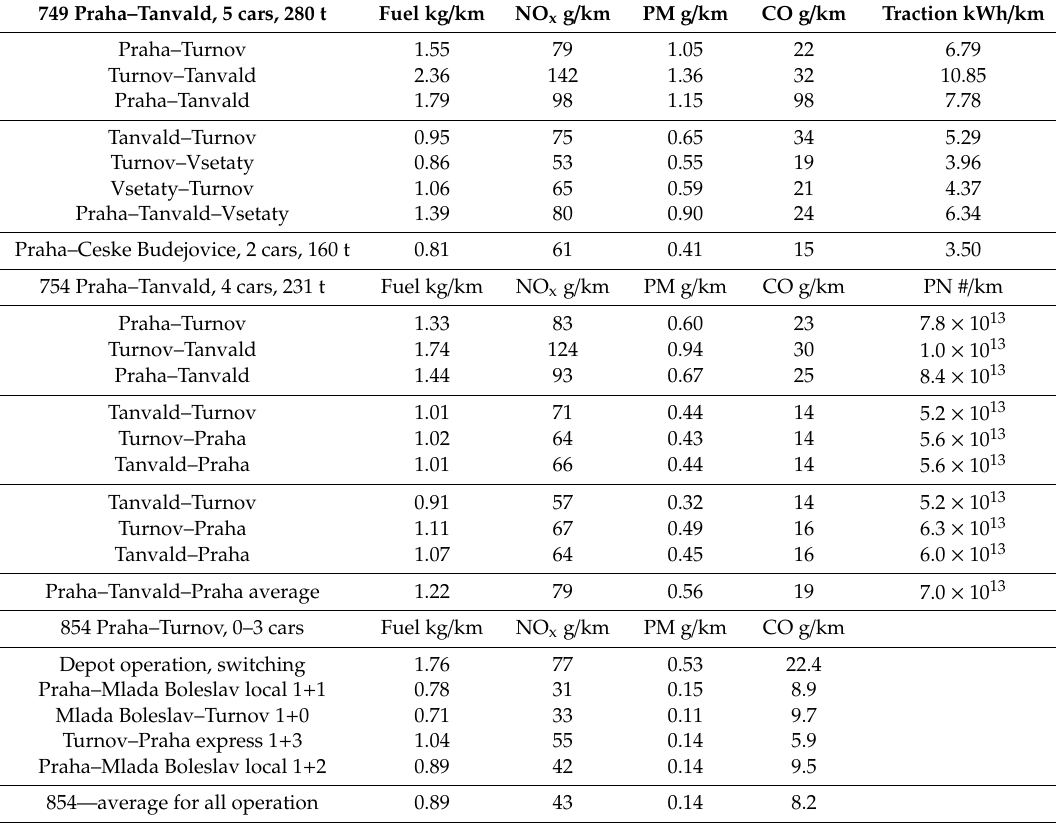
Table 1. Fuel consumption and emissions.